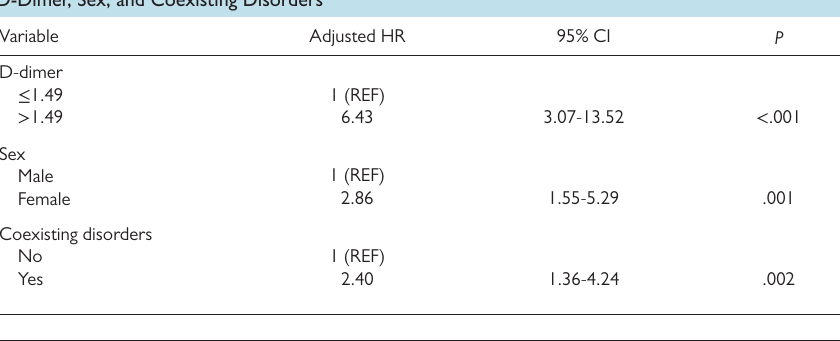
Table 3. C-Statistic Analysis of Routine Laboratory Tests to Predict Mortality in COVID-19 Patients Parameters